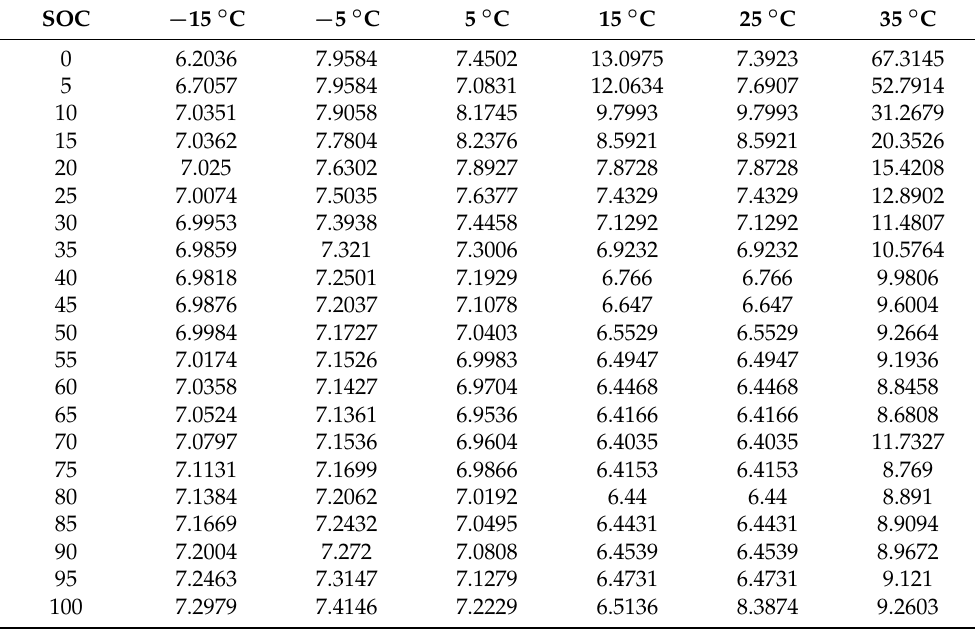
Figure A1. Measurement of charging power control. P EV , EMS is the power requested by the EMS and P EV is the charging power of the EV. Table A1. Values for parameter C 1 in F of electrical model shown in Figure 2 in dependence of cell temperature and